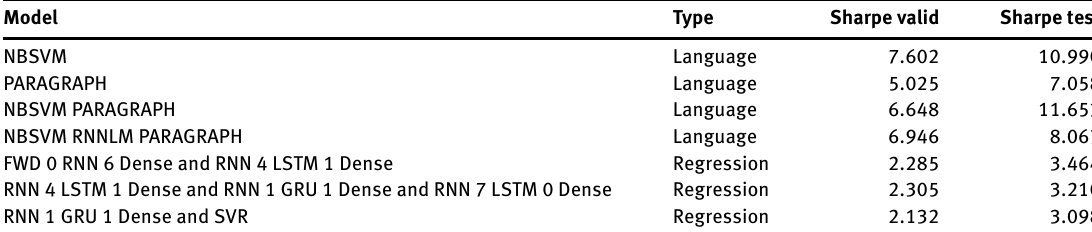
Table 14: Recommended